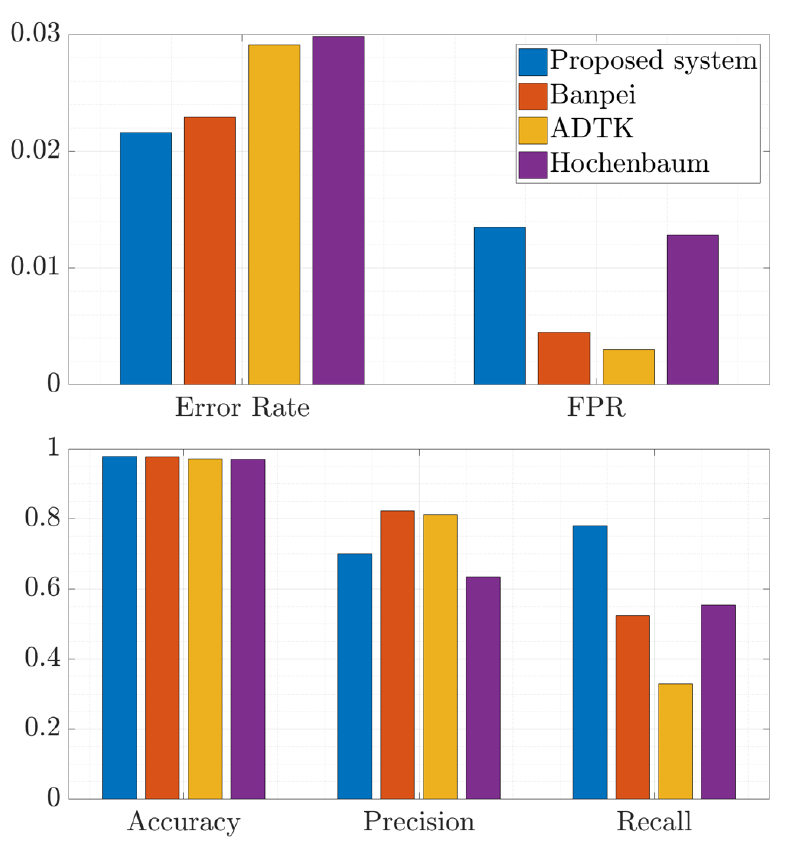
Figure 6. Comparison of the performance achieved by each